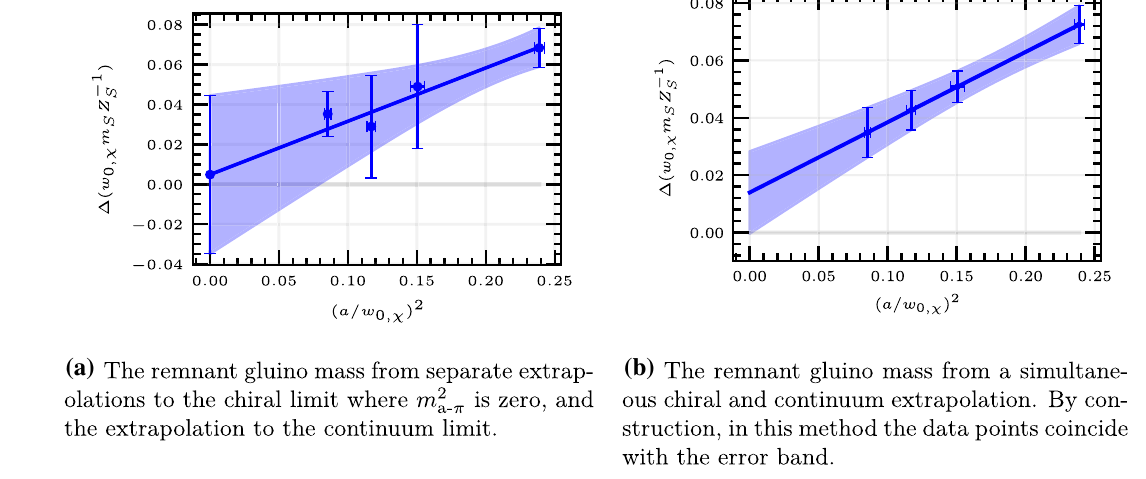
Fig. 3 The remnant gluino mass (cid:17)(w 0 m S Z − 1 the continuum